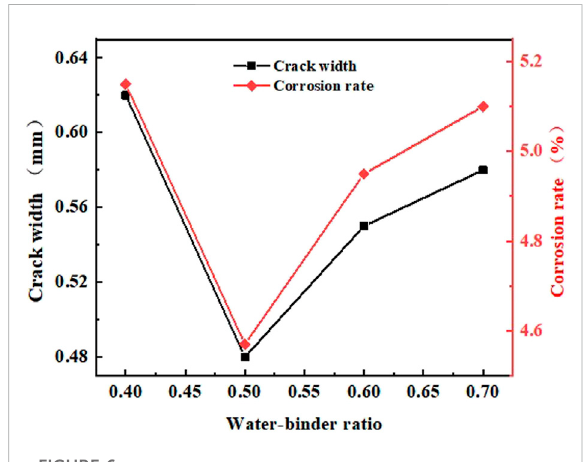
FIGURE 6 Corrosion rate and crack width with water-binder